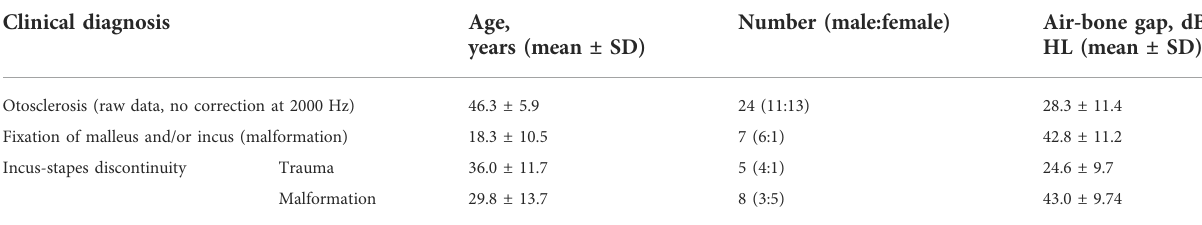
TABLE 1 Data for the clinical cases included in the